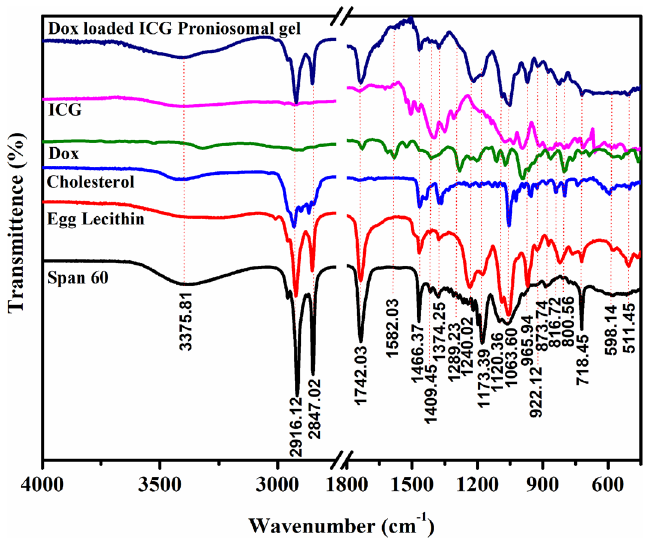
Figure 1. Fourier Transform Infra-Red Analysis of proniosomal